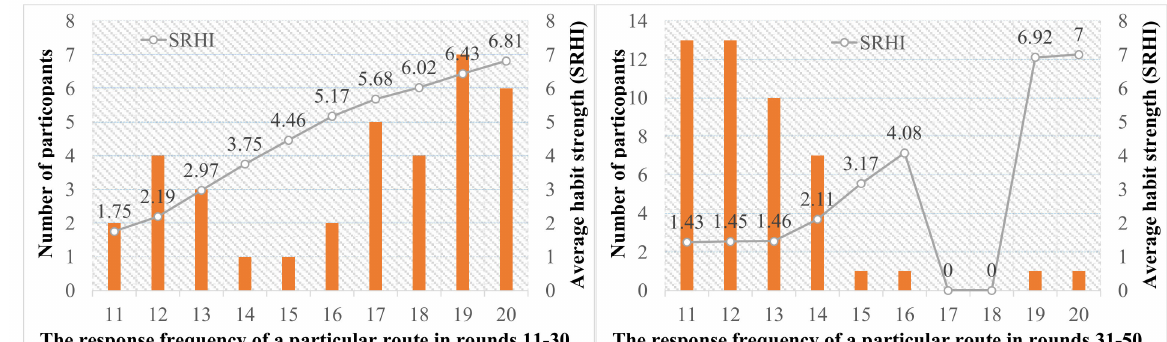
Figure 5. The statistical results of participants’ route choice habit